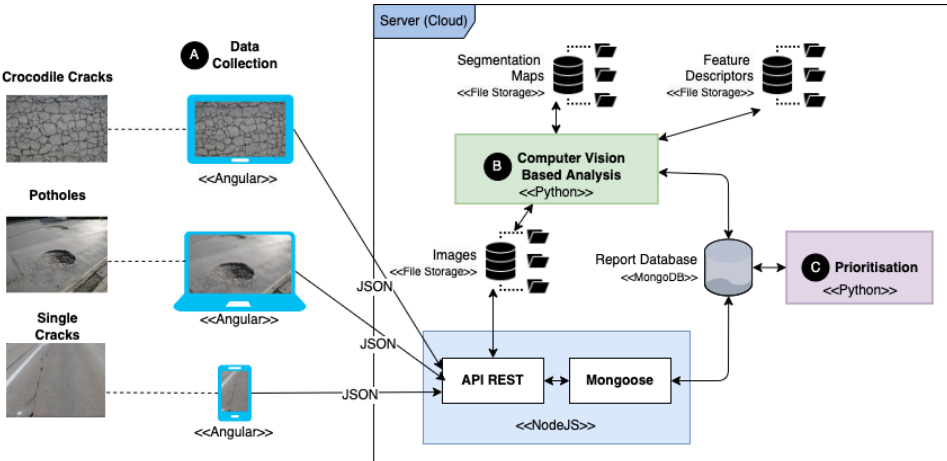
Figure 2. Proposed architecture of a road damage acquisition and analysis system.